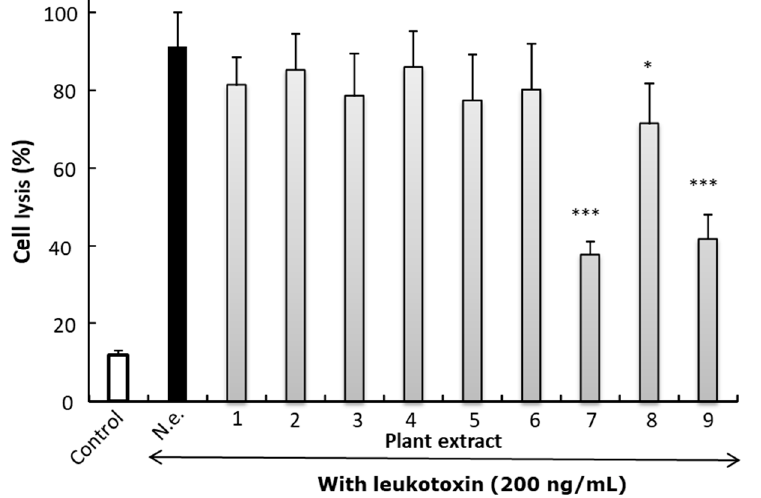
Figure 6. Neutralization of leukotoxicity in the presence of different plant extracts (1%) on cell lysis in cultures of THP-1 cell exposed for leukotoxin (200 ng/mL) in 2 h. N.e.) No extract, (1) W. ugandensis twigs, (2) W. ugandensis leaves, (3) T. asiatica twigs, (4) T. asiatica leaves, (5) Eucalyptus spp. twigs, (6) G. similis (oirii) twigs, (7) Guava ( P. guajava) leaves, (8) fresh extract of W. ugandensis leaves, and (9) fresh extract of W. ugandensis bark. White bar without leukotoxin, black bar with leukotoxin and gray bars leukotoxin + plant extract. Mean ± SD of four experiments analyzed in triplicates. Student’s t- test was used to examine significant difference of leukotoxicity without plant extract ( p < 0.05 *. p < 0.001 ***).